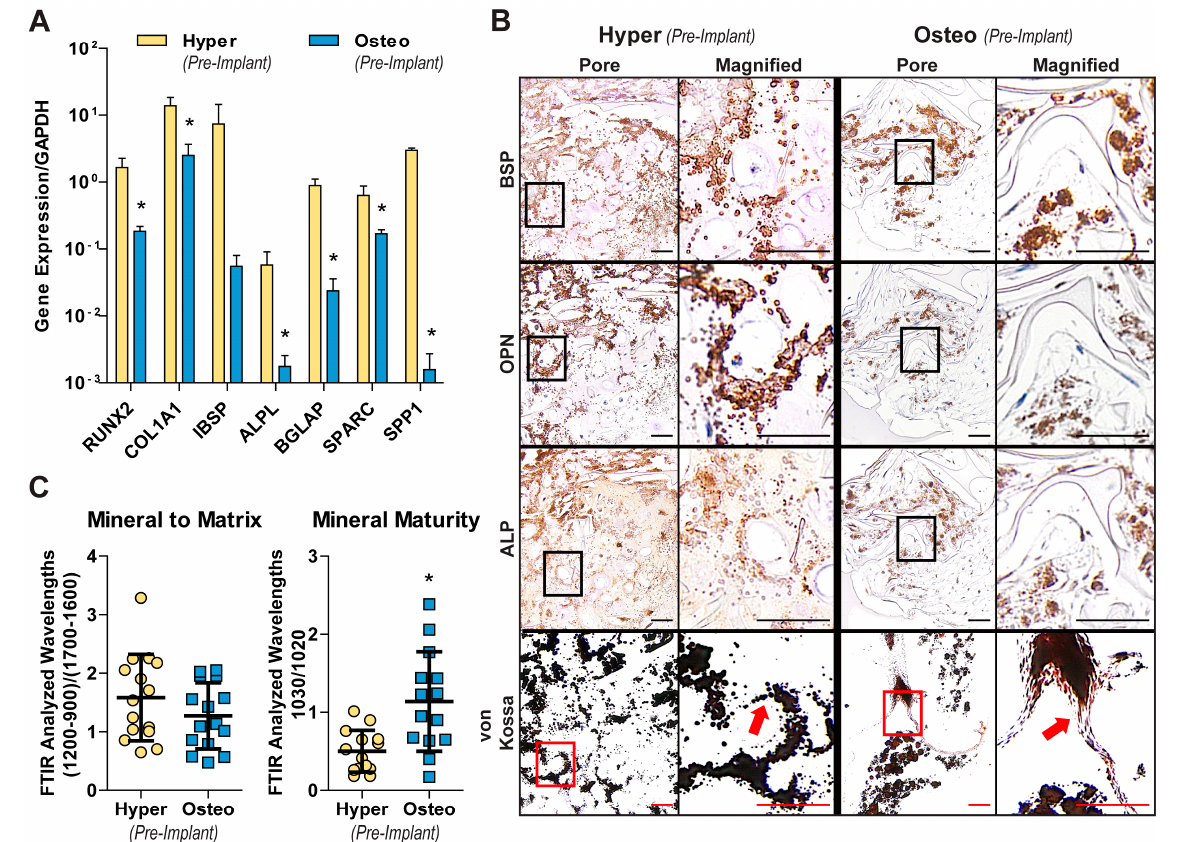
Figure 2. Differentiated cells’ behavior and matrix deposition. ( A ) Expression of the key genes involved in bone development in hypertrophic chondrocyte and osteoblast constructs. The expression levels were normalized to GAPDH ( n = 4). ( B ) Histology and immunohistochemistry at the scaffold pore level and cellular level (magnified images). Representative images are shown for von Kossa, BSP, OPN and ALP staining to demonstrate the differences in the deposition patterns. Red arrows point to the differences in the mineral’s appearance, with the hyper constructs containing globular mineral deposits and the osteo constructs depositing mineral along the scaffolds’ surfaces. Scale bars: 50 µm. ( C ) Mineral composition within the newly formed bone matrix, as determined by FTIR analysis of the mineral–matrix ratio and the maturity of the mineral ( n = 16). Data ( A , C ) are shown as the average ± SD. * significant differences between the groups ( p < 0.05).